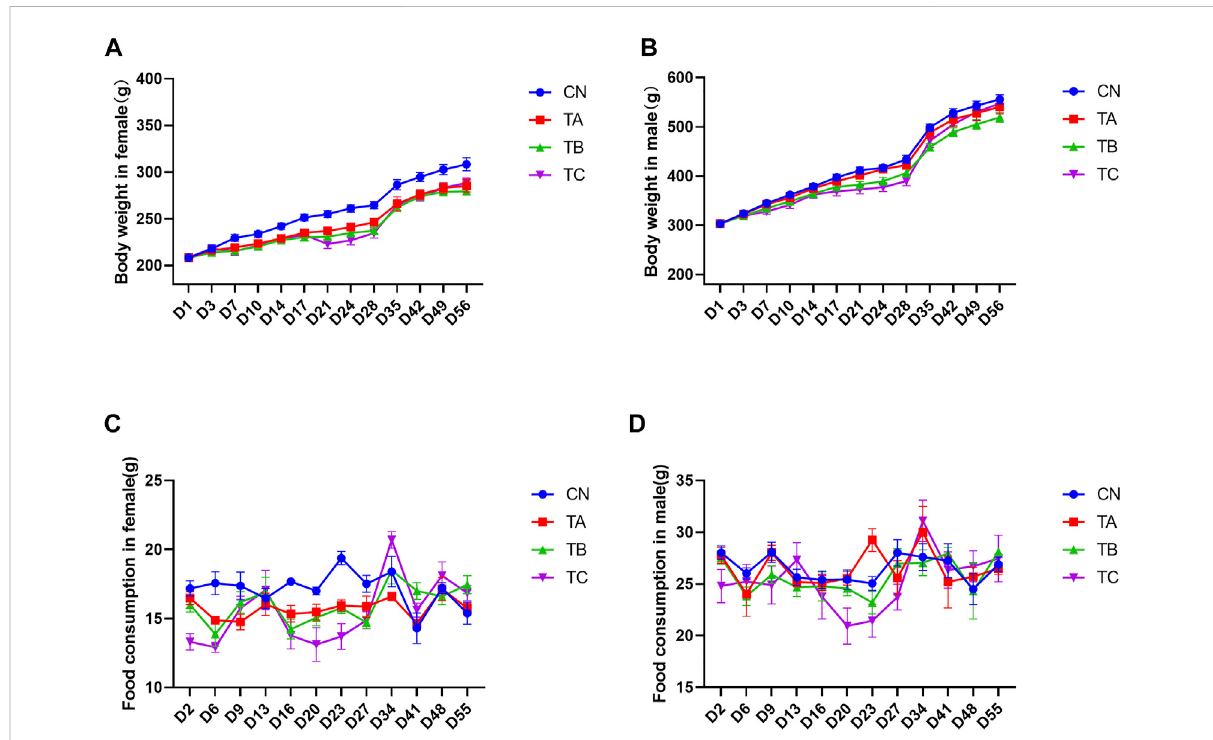
FIGURE 2 Effects of different doses of QZZD on the body weight in female (A) or male (B) rats and food consumption in female (C) or male (D) rats. In the treatmentperiod, n =18ineachgroup,andtwofemalerats(4110and4111)deathcausedbyfaultygavageoperation,thetotalnumberwas16( n =16) in TC female group. In the recovery period, n = 6 in each group for female or